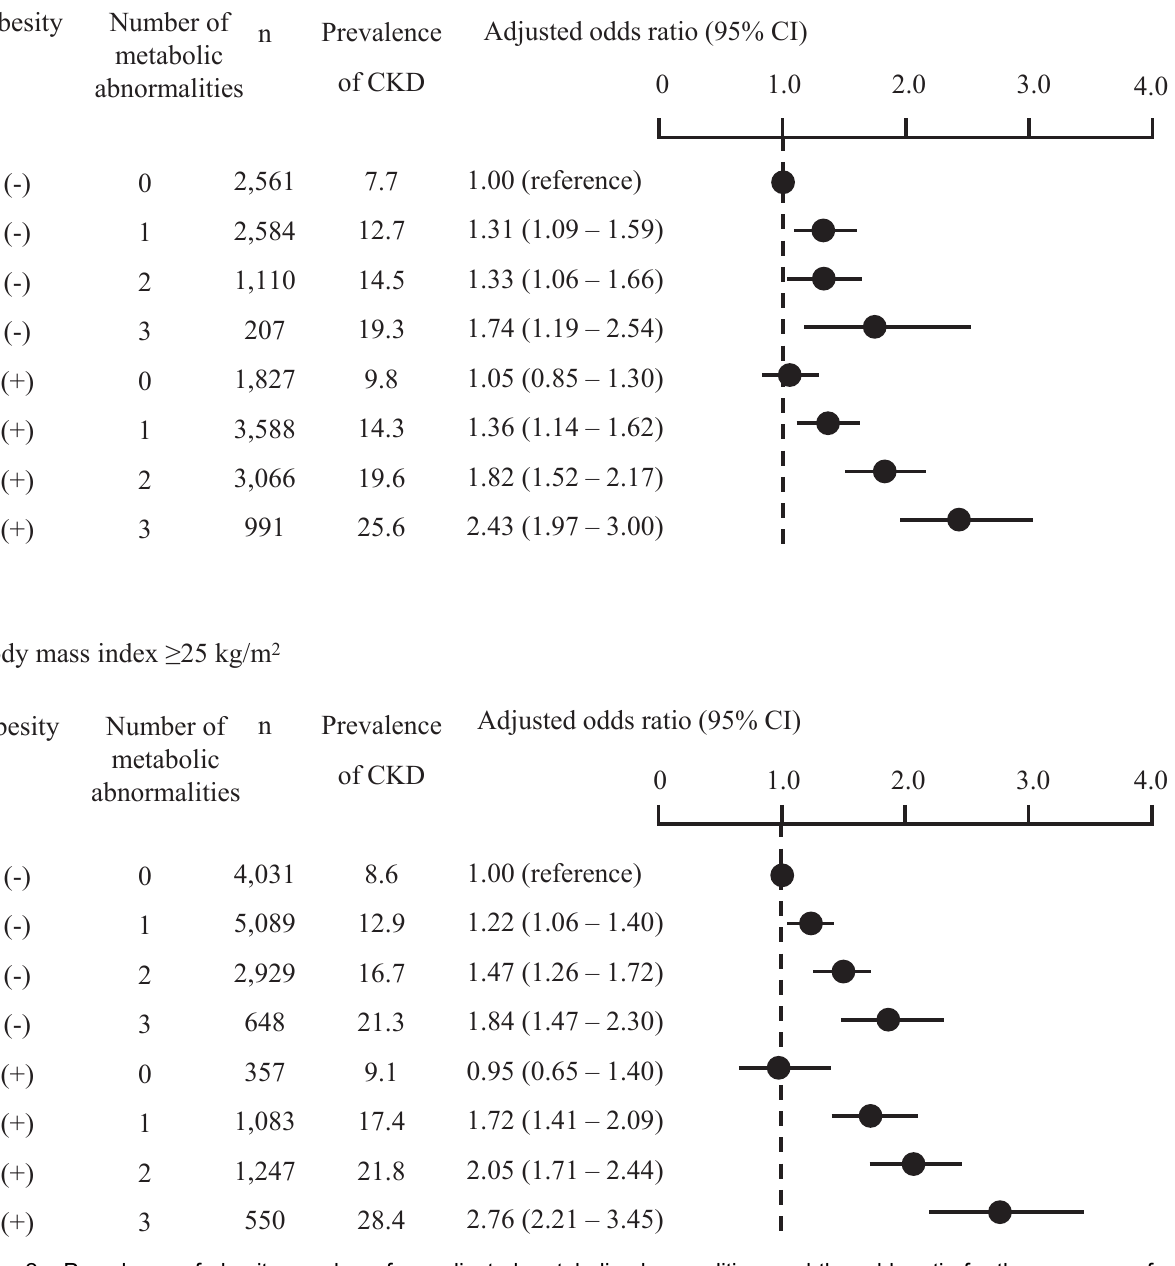
Figure 2. Prevalence of obesity, number of complicated metabolic abnormalities, and the odds ratio for the presence of chronic kidney disease in Japanese women. Obesity was de fi ned by (A) the cut-off point for waist circumference according to the de fi nition of metabolic syndrome for Asian women (80cm), and (B), the BMI cut-off point of 25kg/m 2 . Odds ratios were adjusted for age, smoking status, and alcohol consumption. CI, con fi dence interval; CKD, chronic kidney